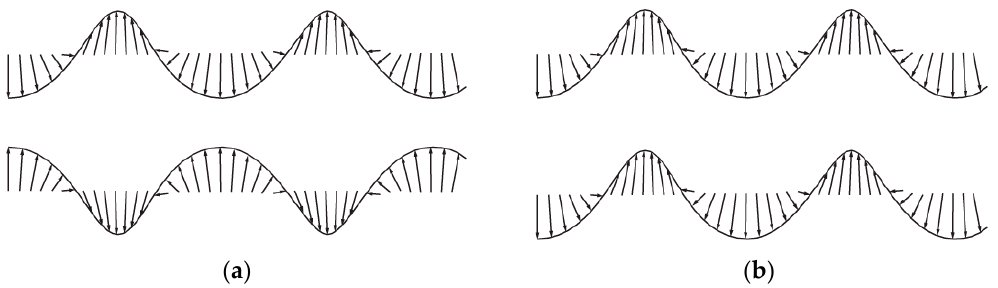
Figure 2. Schematic of ( a ) symmetric particle displacement ( b ) antisymmetric particle displacement (adapted from [10]) .